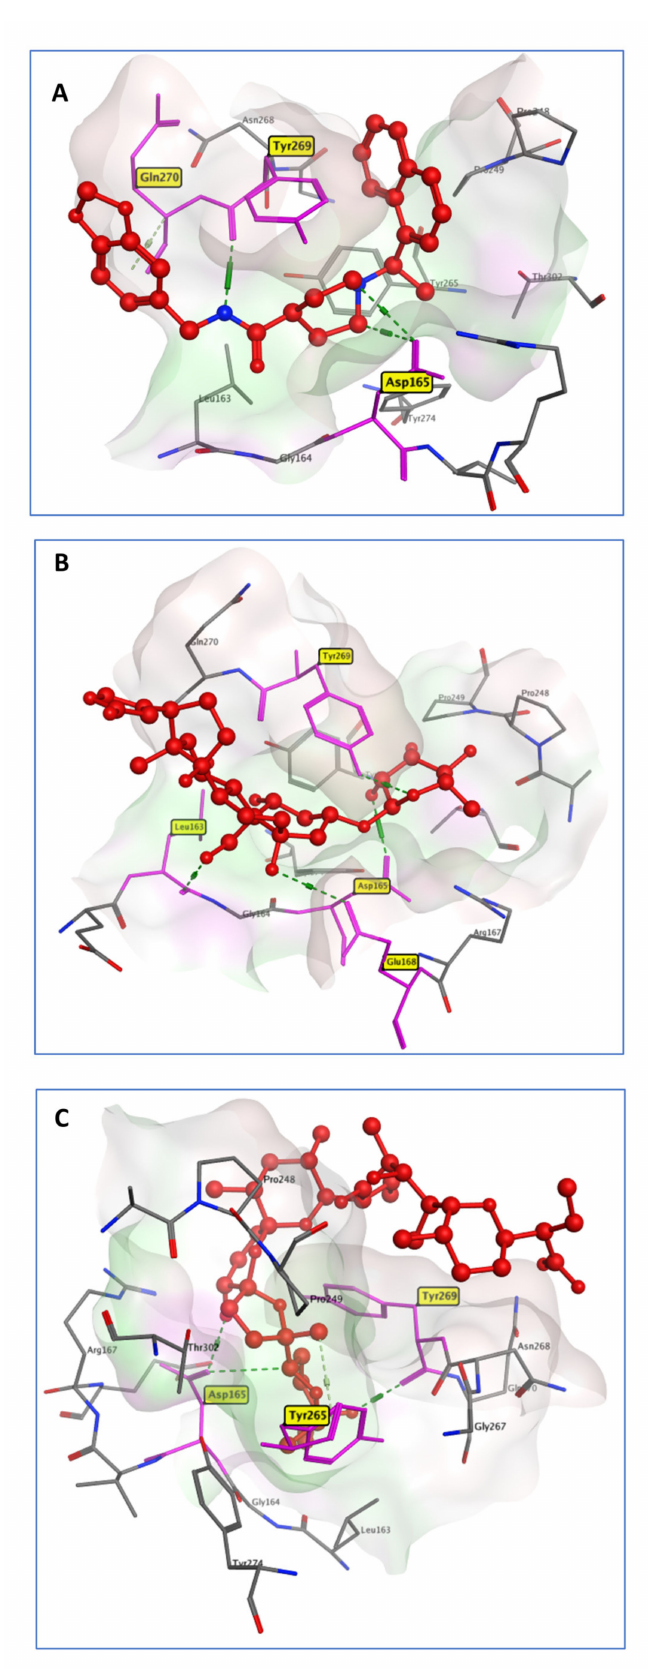
Figure 1. 3D model of the interactions between cocrystallized ligand GRM ( A ), OUB ( B ), and SLM ( C ) with PLpro active site